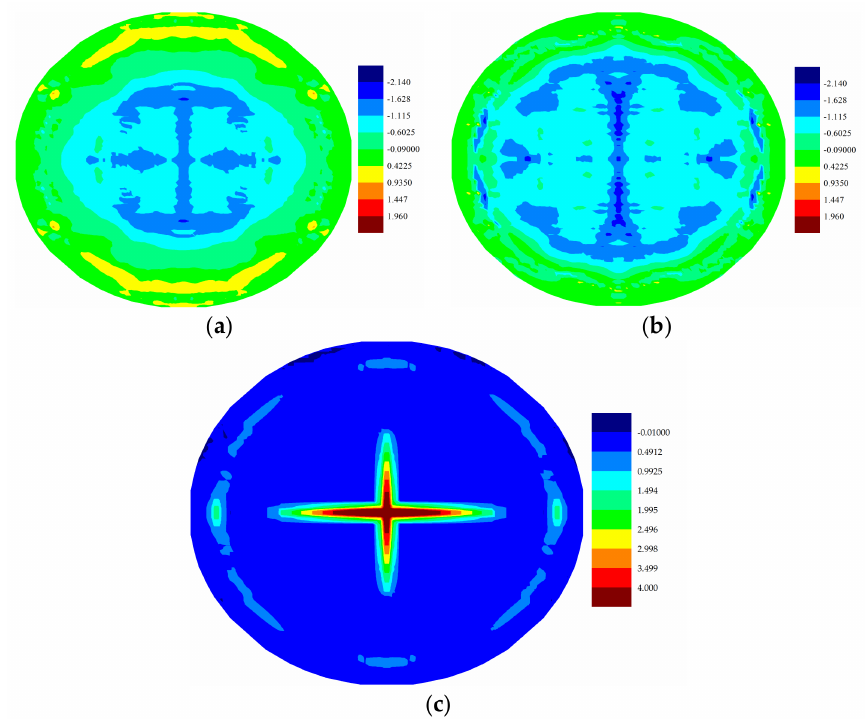
Figure 23. ( a ) Distribution of temperature change (K) of bottom ply at 0.28453 × 10 − 3 s; ( b ) Distribution of temperature change (K) of bottom ply at 0.3461 × 10 − 3 s; ( c ) Maximum stretch distribution of bottom ply at 0.3461 × 10 − 3